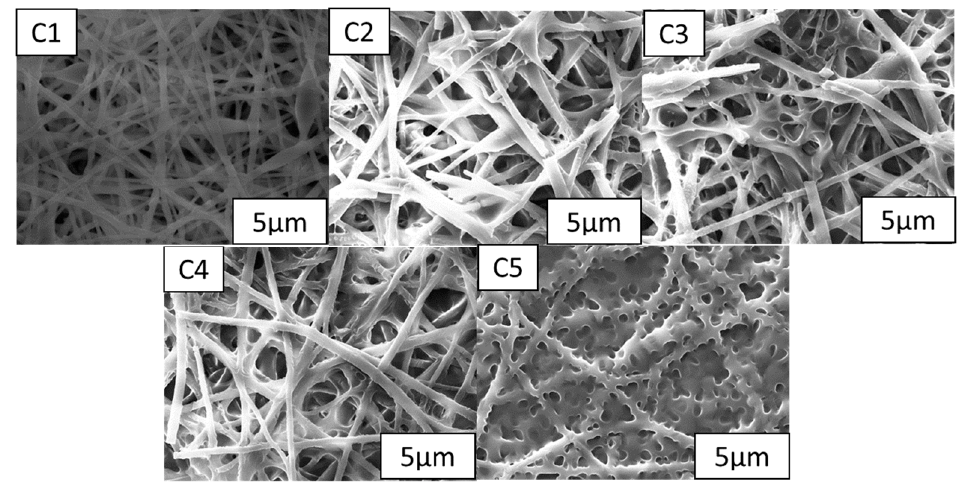
Figure 7. Network of the polymer matrices in specimens ( C1 – C5 ).